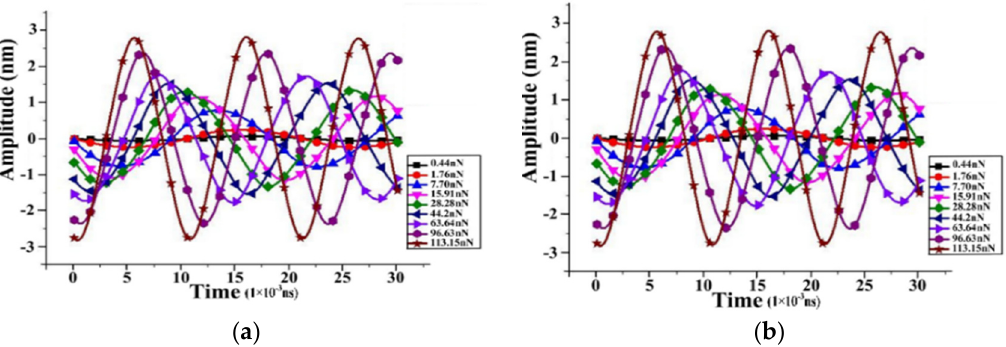
Figure 8. Absolute displacement of central atom in the normal direction with different external loading: ( a ) Single vacancy defect; ( b ) Edge defects.